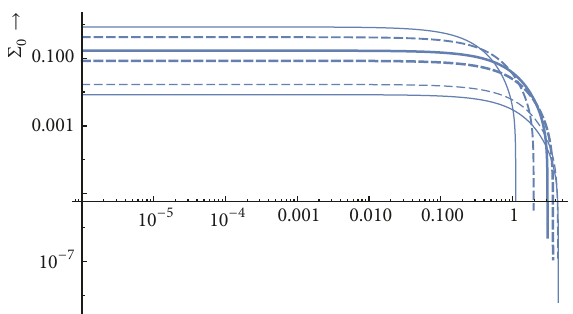
Figure 2: The shape of the differential cross section as a func- tion of the electron energy 𝑇 in eV for the WIMP masses (1,2,5, 10, 50, 100)𝑚 𝑒 . The electrons are assumed to be free. The WIMP masses specifying the curves are increasing downwards. The spectrum does not exhibit any special